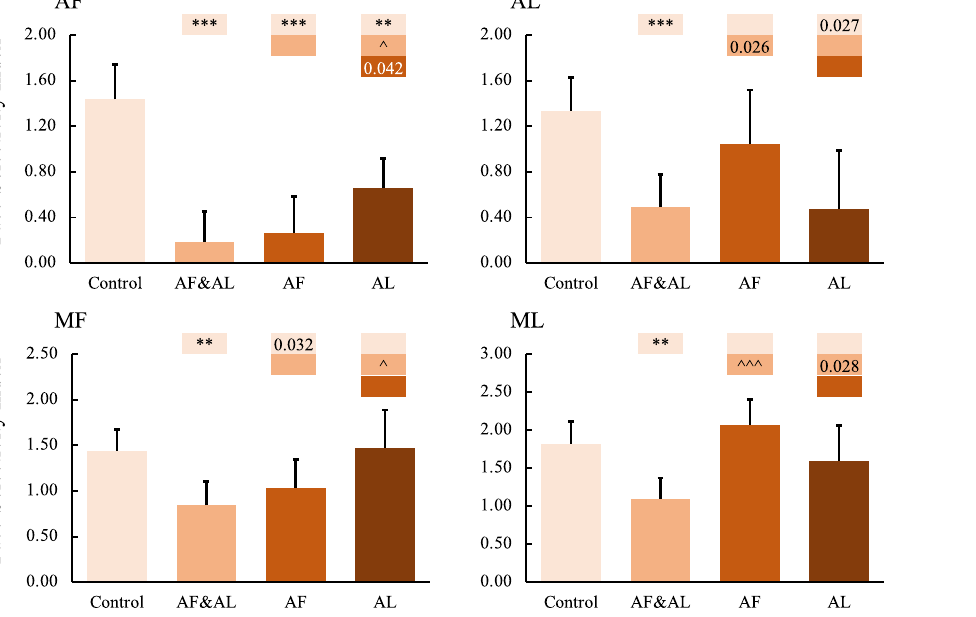
difference from control (** p <0.01, *** p <0.001, in light red/blue boxes); ^sig- ni fi cant difference from combined AF and AL inactivation (^ p <0.05, ^^^ p <0.001, in middle red/blue boxes); value, uncorrected p value; empty bar, no signi fi